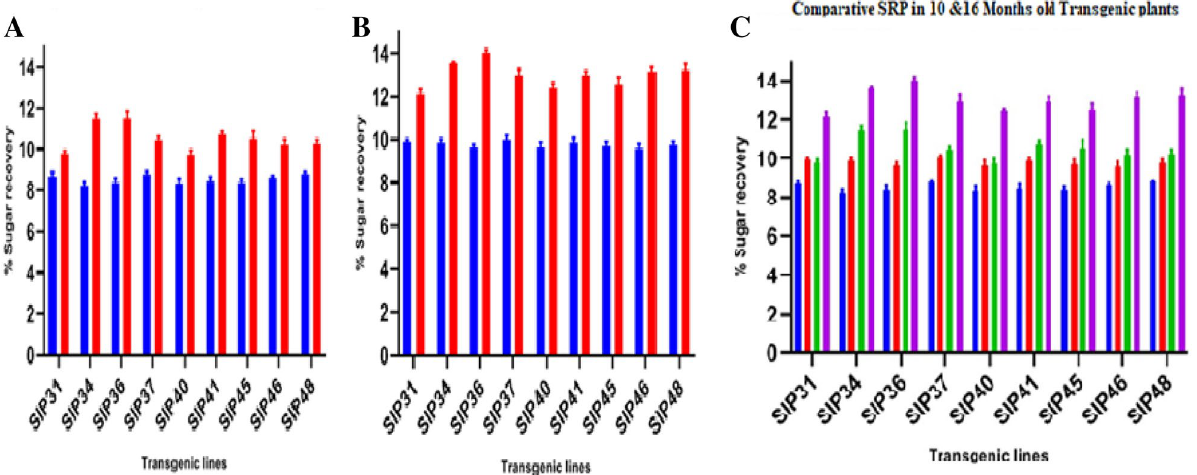
Figure 8. ( A ) The estimation of SRP after 10 months of maturity. ( B ) Estimated SRP after 16 months of plant maturity. Blue bars witnessed SRP levels in control lines while red bars indicate SRP levels in transgenic lines ( C ) Comparative SRP estimation after 10 and 16 months of maturity in transgenic and control lines. Blue bars represented 10 months old control lines, red bars indicate 16 months old control plants SRP estimations, green bars exhibited SRP levels in transgenic lines at 10 months stage whilepurple color bars are the representatives of 16 months old transgenic sugarcane lines.